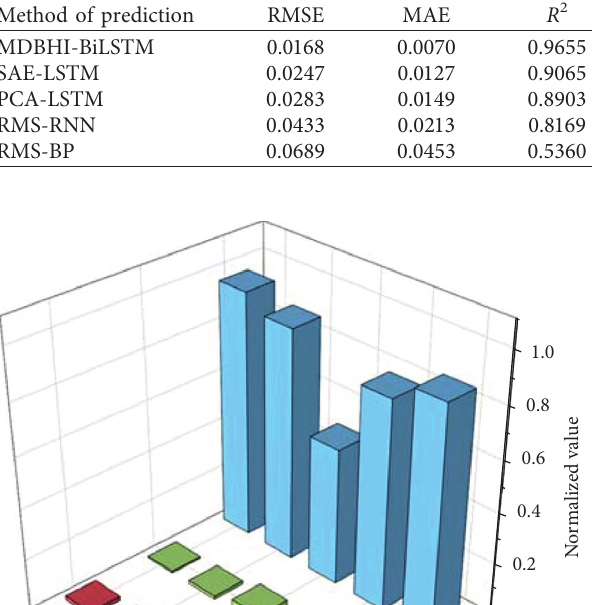
Table 4: Comparison of five prediction performance measures. Method of prediction